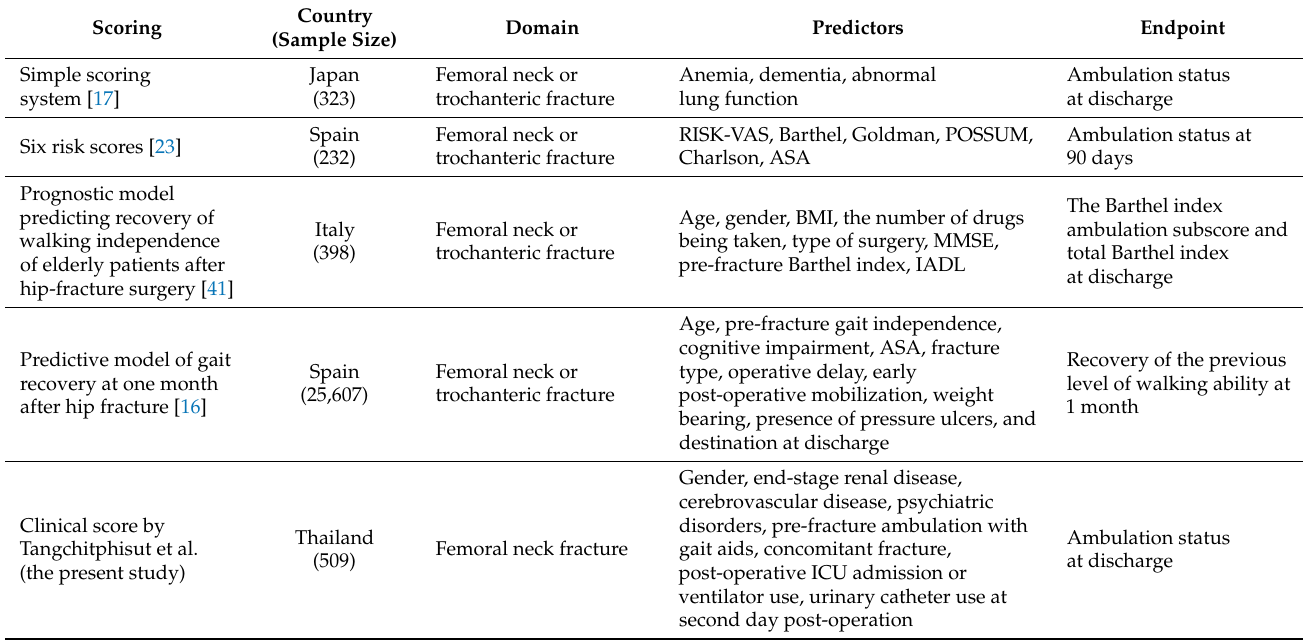
Table 5. Methodological characteristics of previously reported clinical scoring systems for prediction of post-operative ambulatory status in patients with femoral neck